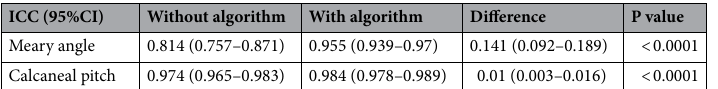
Table 2. Interobserver interclass correlation coefficient.